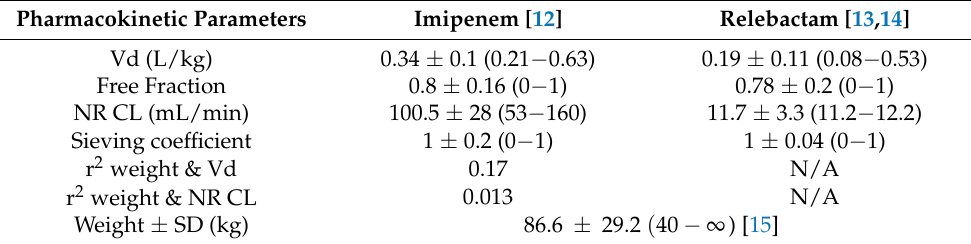
Figure 2. ( a ) Imipenem continuous hemodialysis transmembrane clearance; ( b ) Relebactam continuous hemodialysis transmembrane clearance. Figure 3. Probability of target attainment for imipenem dosing regimens, for a CRRT effluent rate of 25 mL/kg/h. Relebactam was not included in the figure, because it reaches a PTA ≥ 90% at all times.